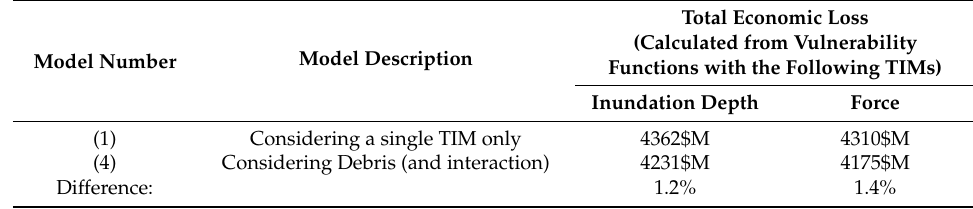
Figure 7. A comparison of vulnerability curves (mean damage ratio (MDR) vs. TIM), for all engineered buildings, those struck by debris and those not-struck by debris. Note that the curves pass through the origin, but increase instantly for all non-zero TIM values. Table 5. A comparison of indicative estimated losses due to building damage, for engineered